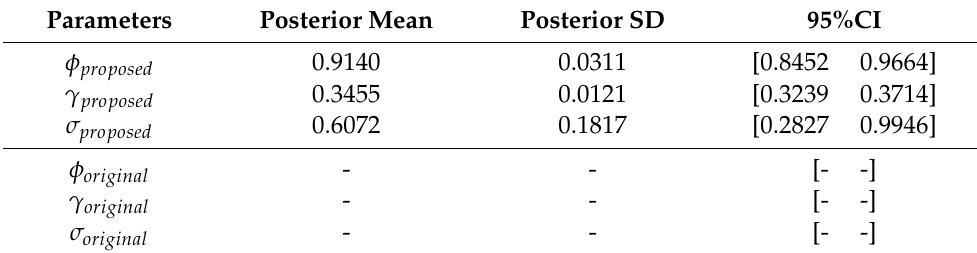
Table 39. Comparison of estimated parameters (23 June 2016, JAL, Tokyo, Japan).